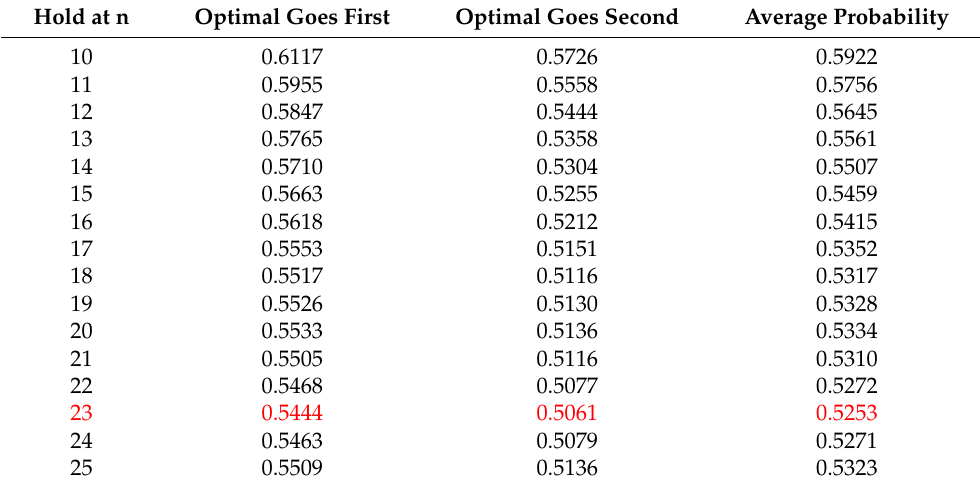
Table A2. Detailed winning probabilities of the optimal strategy against the “hold at n” strategy, for the standard two-dice Pig game. Here the “hold at 23” is the best choice with the average winning chance against the optimal strategy being 0.4747 (= 1 −